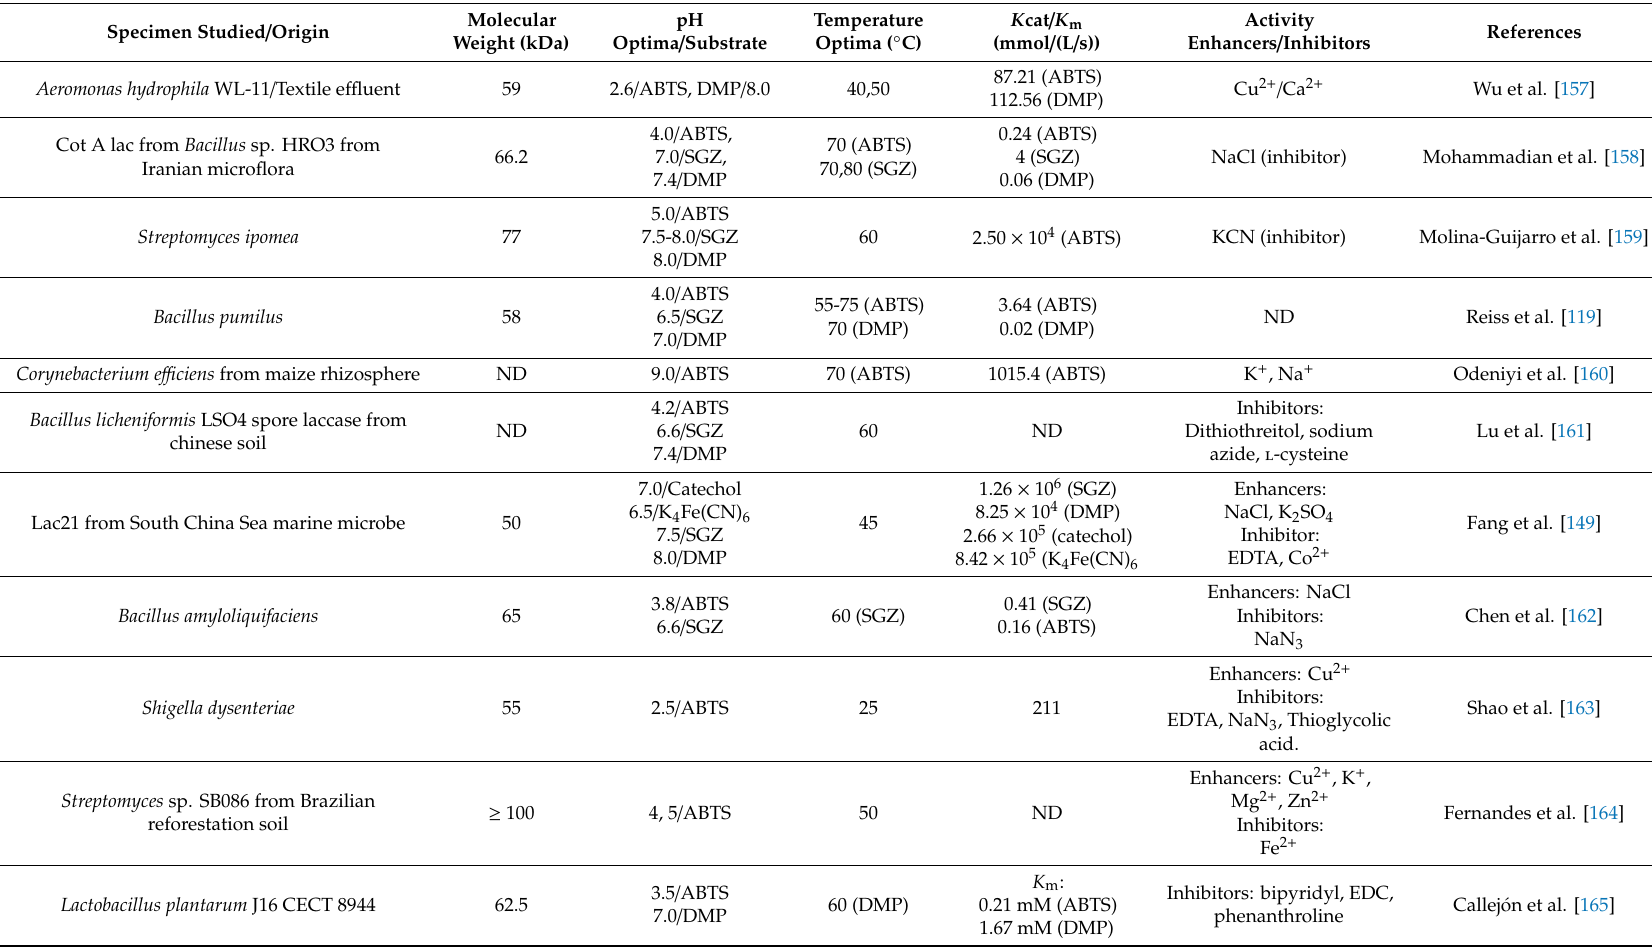
Table 1. Physicochemical and catalytic properties, and substrate specificities of some bacterial